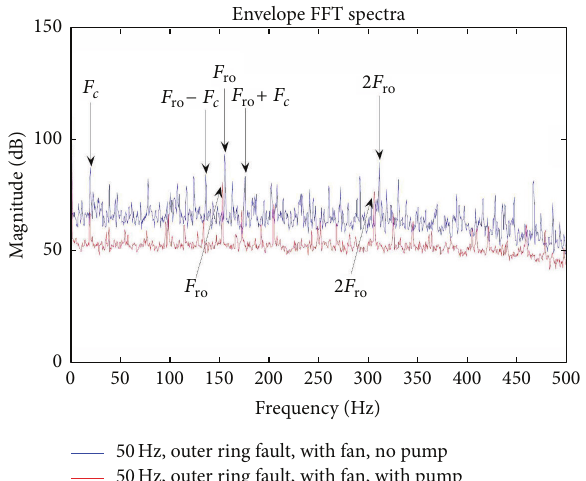
Figure 10: Outer defect spectra of 50 Hz motor input, different load conditions (fan load and pump load), and radial vibration measurements.